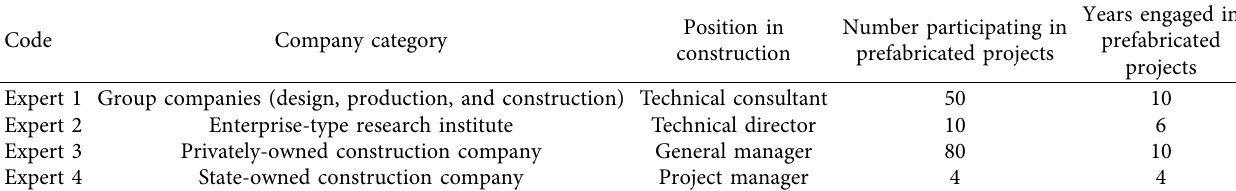
Table 2: Basic information from the four experts interviewed and